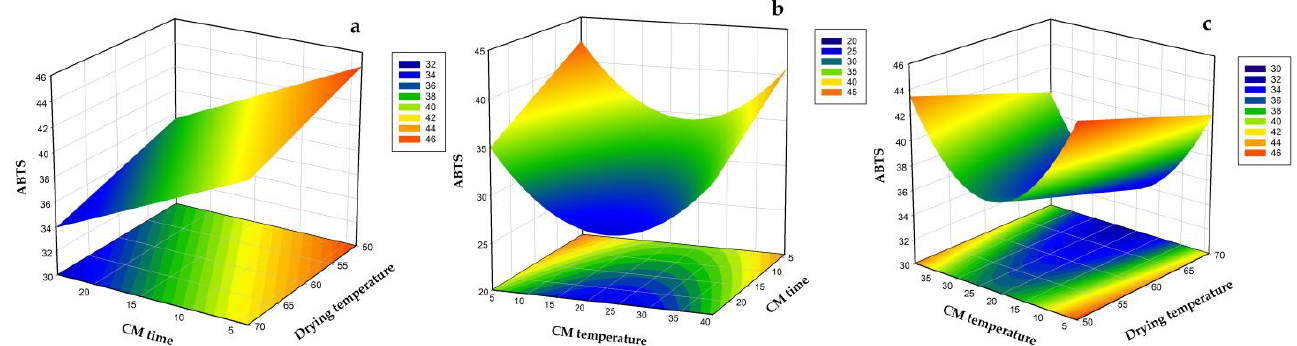
Figure 5. Influence of ( a ) CM time (h) and drying temperature (°C), ( b ) CM temperature (°C) and CM time (h), and ( c ) CM temperature (°C) and drying temperature (°C) on ABTS (µmol T.E/g DM) of dried strawberries with CM pre-treatment.